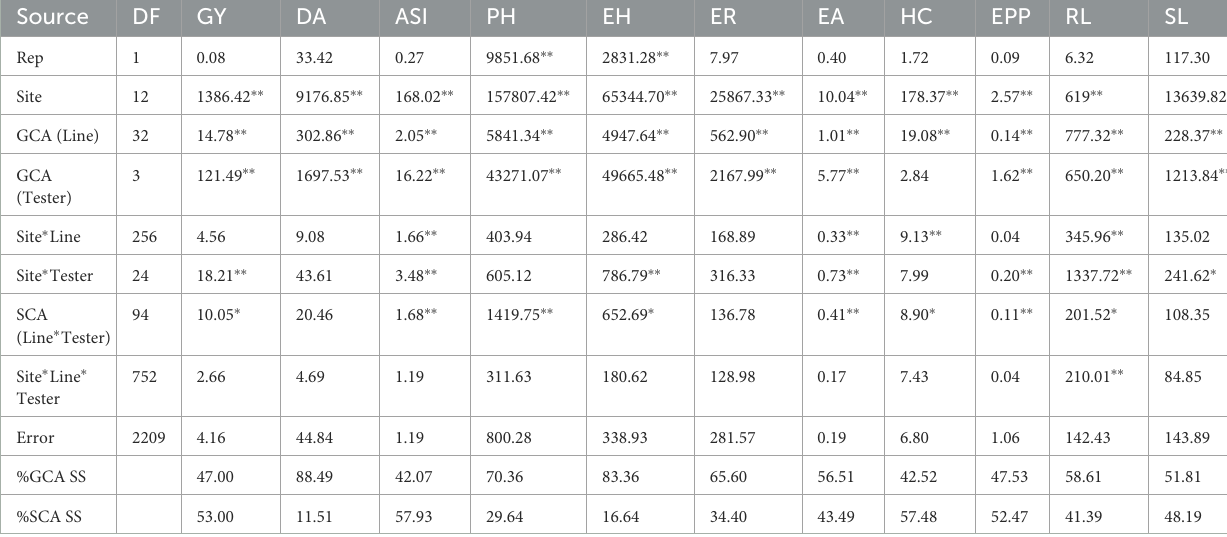
TABLE 2 Mean squares from analysis of variance for general and specific combining ability for grain yield and other agronomic traits across 13 locations in South Africa and Zimbabwe during the 2018 and 2019 cropping seasons.